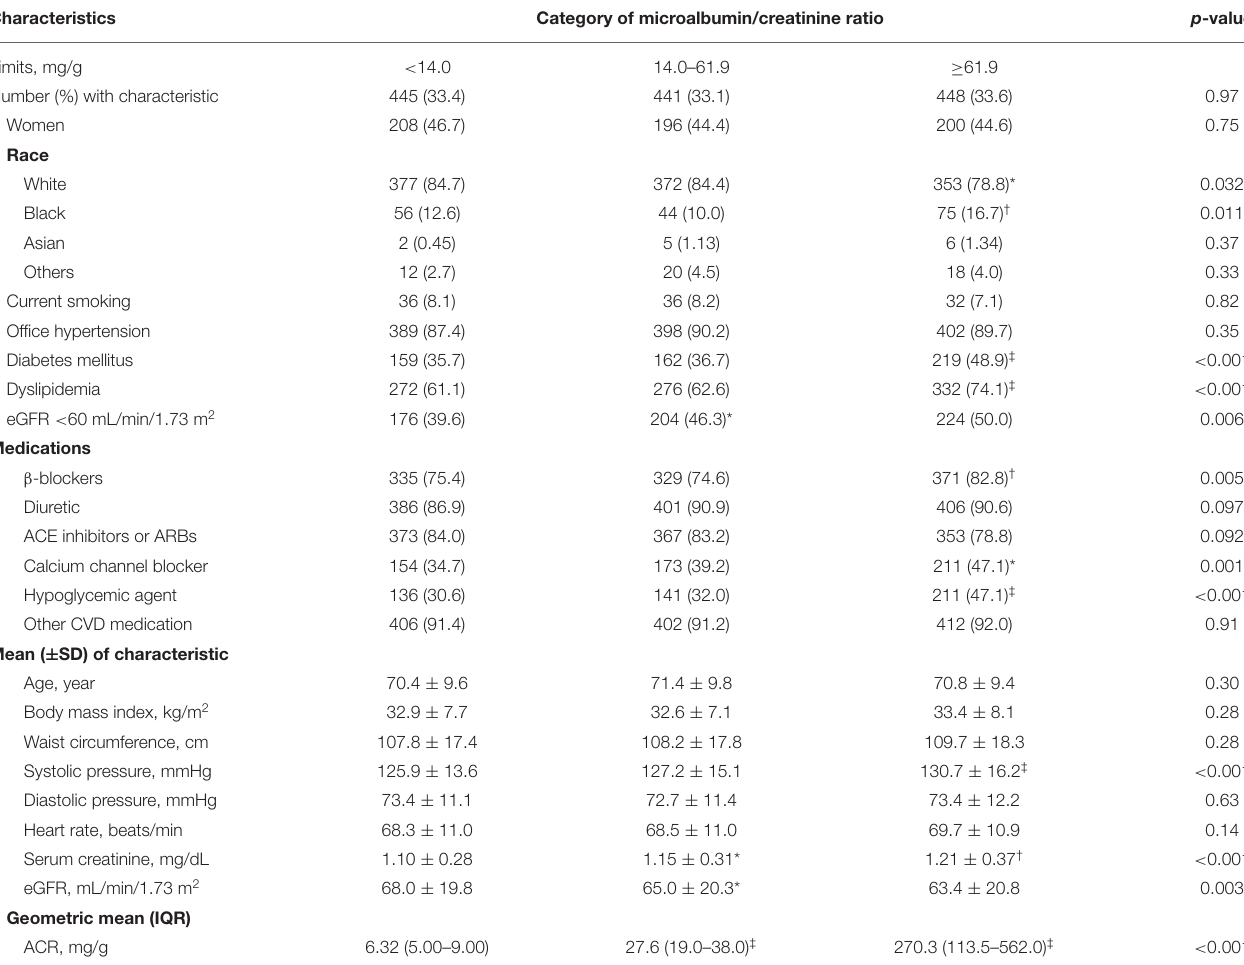
TABLE 1 | Baseline characteristics of participants by tertiles of the microalbumin/creatinine ratio distribution.